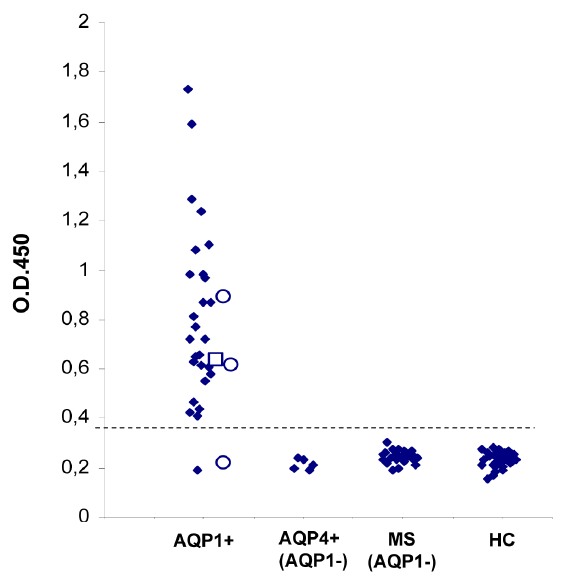
Figure 4. Detection of binding of anti-AQP1 antibody to denatured AQP1 by Western blotting. Yeast-expressed AQP1 was electrophoresed and transferred onto nitrocellulose membranes, which were then incubated with the test sera (see Methods). Lanes 1-3: Three sera from healthy controls at dilutions 1/250, 1/60, and 1/30, respectively; lane 4: commercial rabbit anti-AQP1 antibody; lanes 5-8: representative anti-AQP1-positive sera with titers of 132, 25, 10.5, and 5.8 nM, at dilutions of 1/500, 1/250, 1/30, and 1/30, respectively. None of the test anti-AQP1 sera bound to the control protein MuSK (not shown).